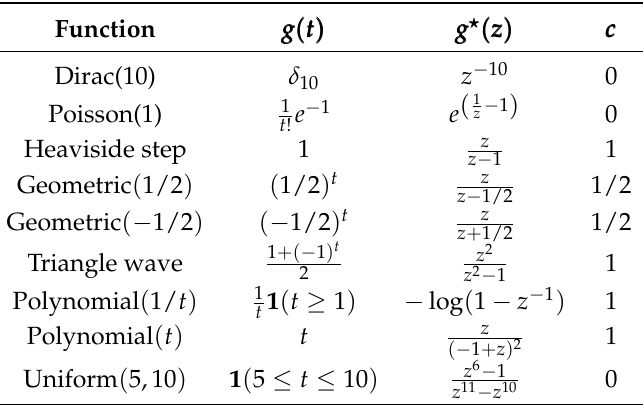
Table 1. Set of test